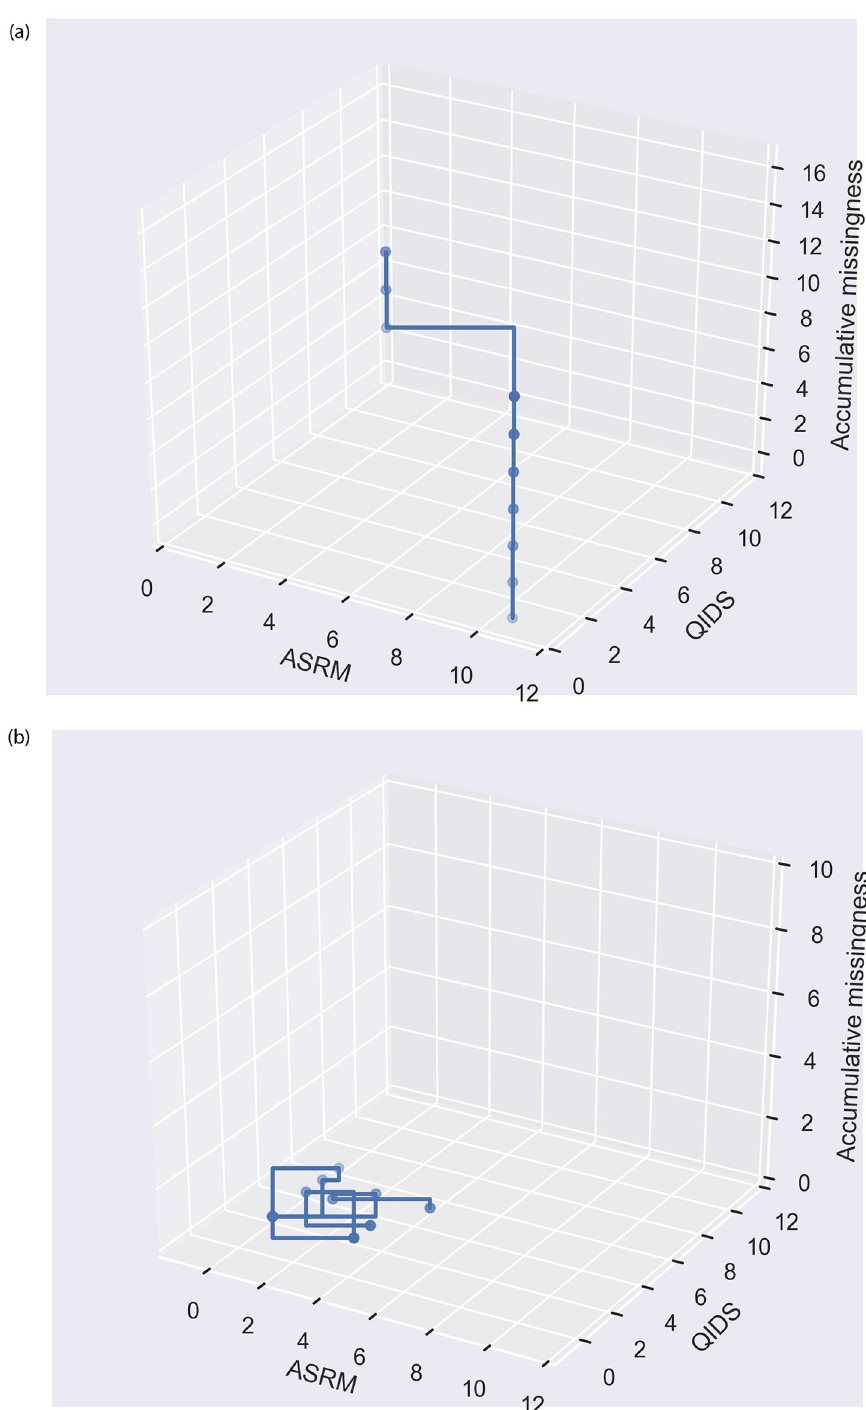
Fig 6. One participant who who did not miss a week. Randomly sampled ten-week data trajectory (weekly self- reported scores from ASRM, QIDS and missingness) of two participants who were recognised by MRLSM only. One participant missed over 70% weeks and another one did not miss a week. (a) One participant who missed over 70% weeks. (b) One participant who who did not miss a week.